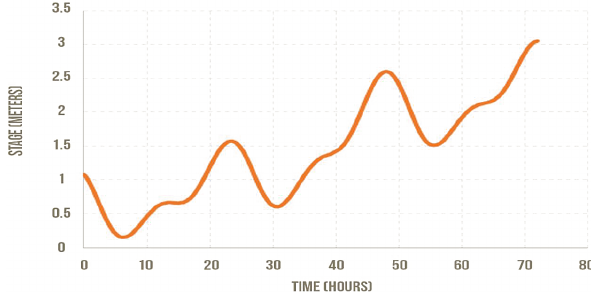
Figure 6. Example storm tide of Metro